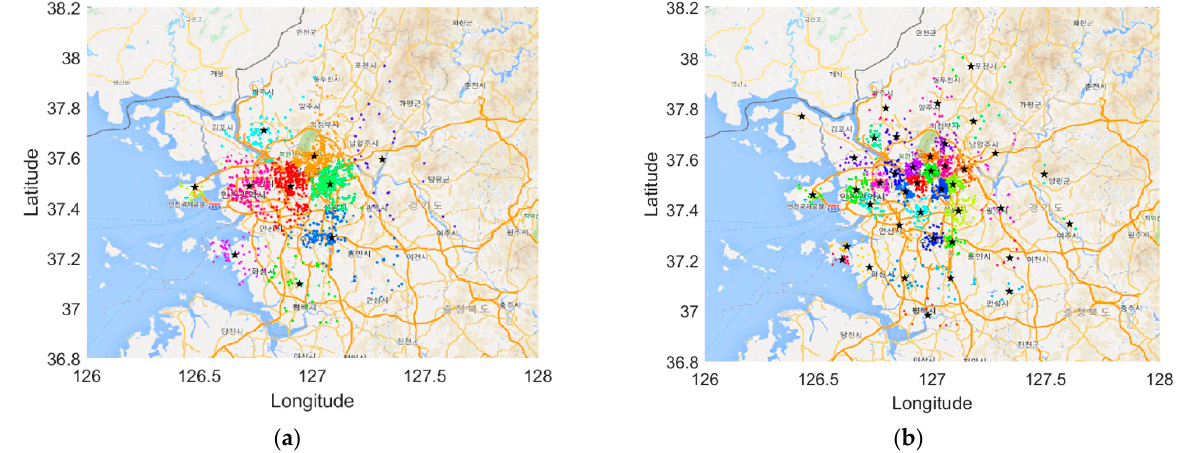
Figure 9. ( a ) Result of clustering when the number of vertiports is 10; ( b ) result of clustering when the number of vertiports is 40.